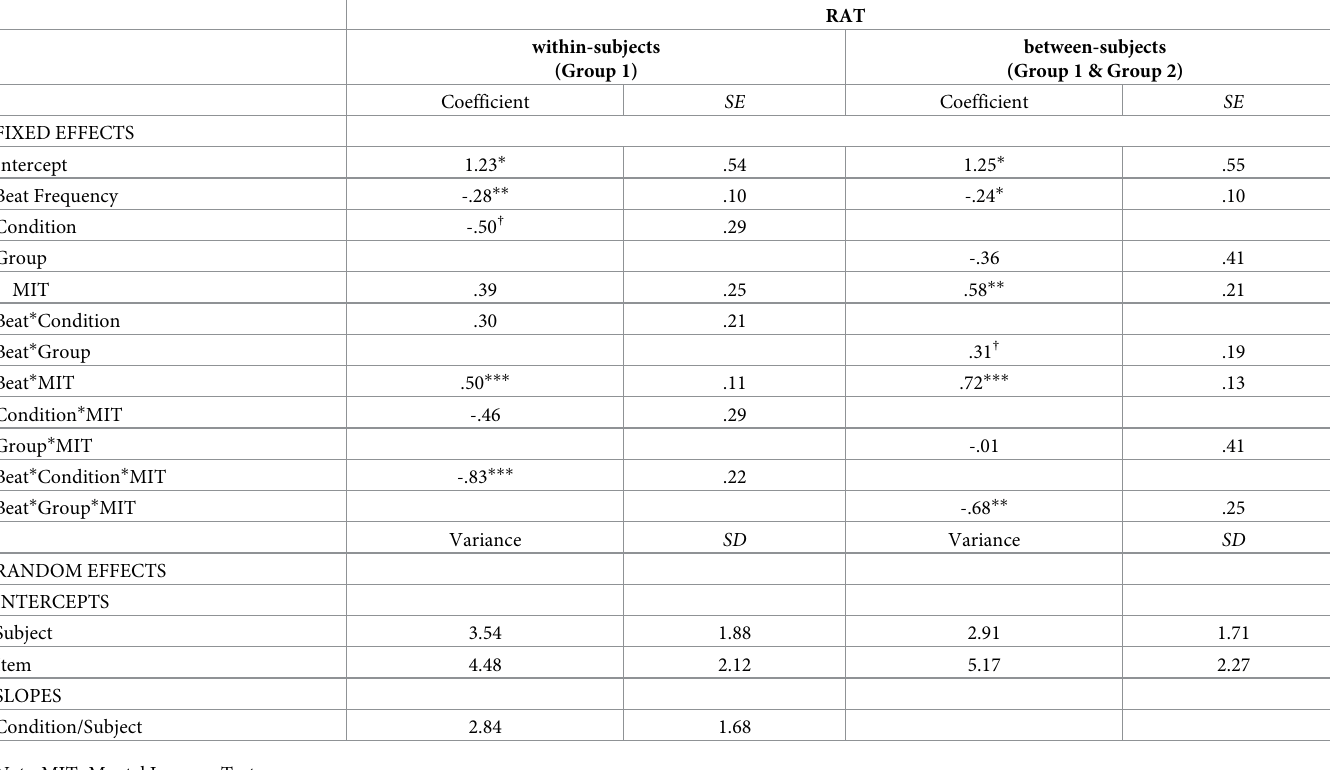
Table 4. Model summary for Hypothesis 2—Beat